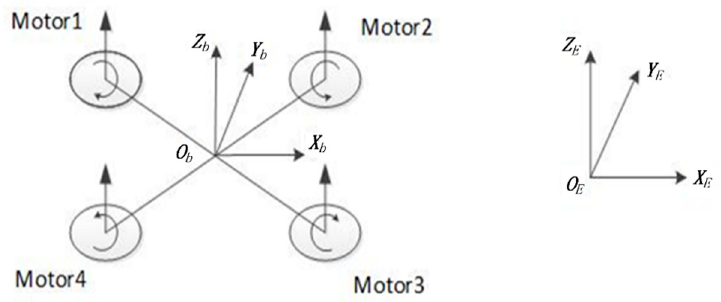
Figure 2. An airframe coordinate system and a geographic coordinate system.